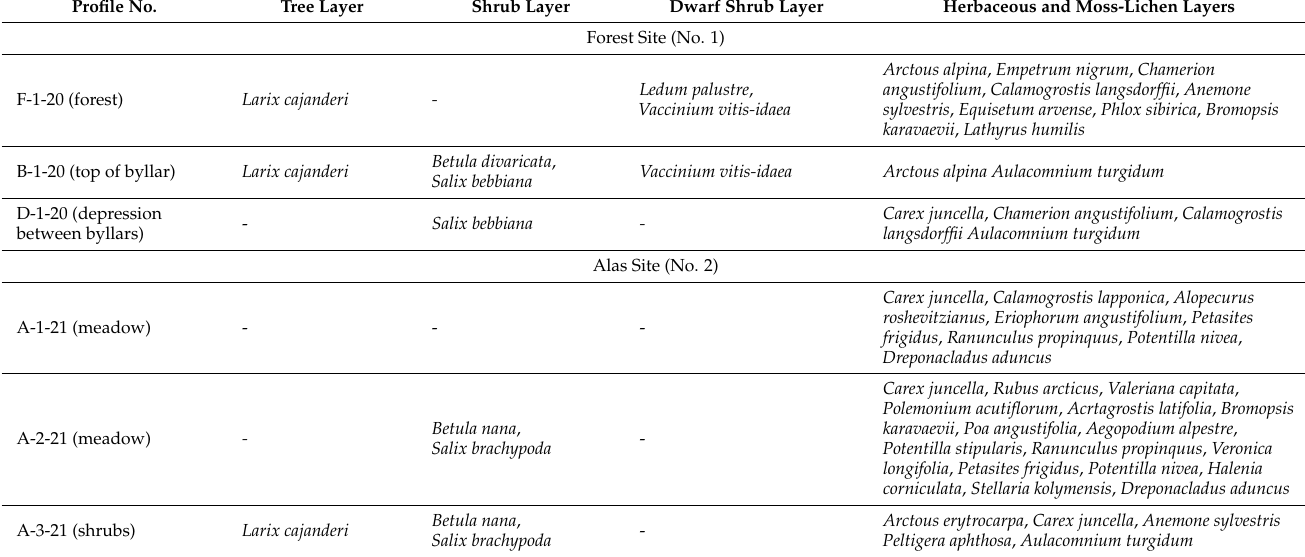
Table 1. Composition of woody and herbaceous species of study sites.